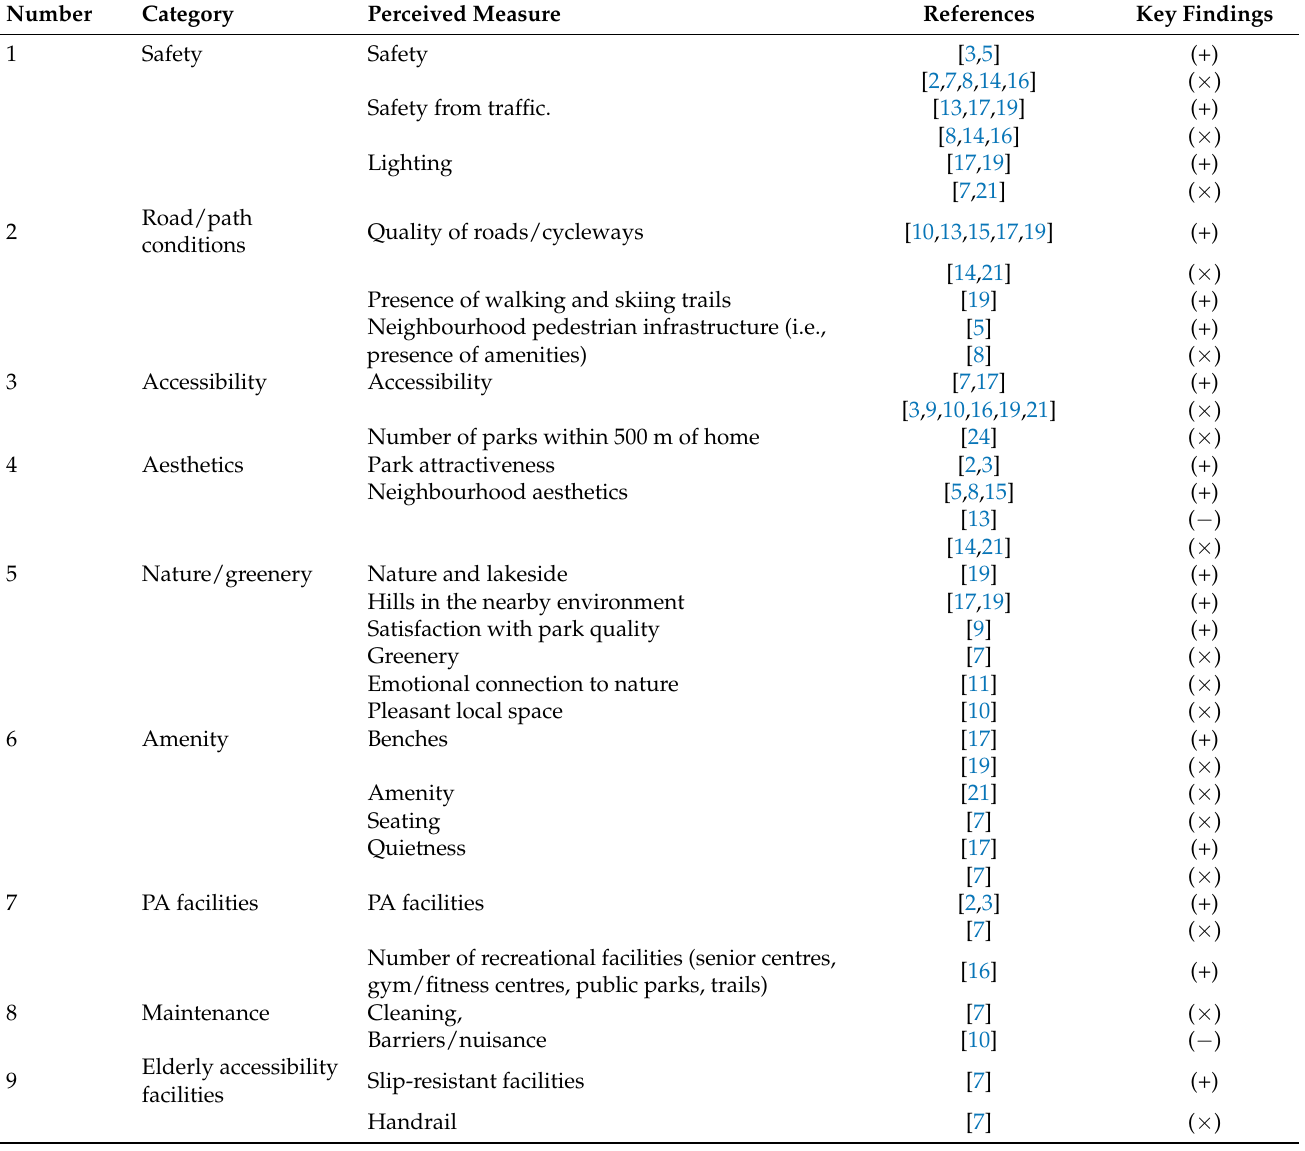
Table 4. Summary of the significance of perceived measures of landscape